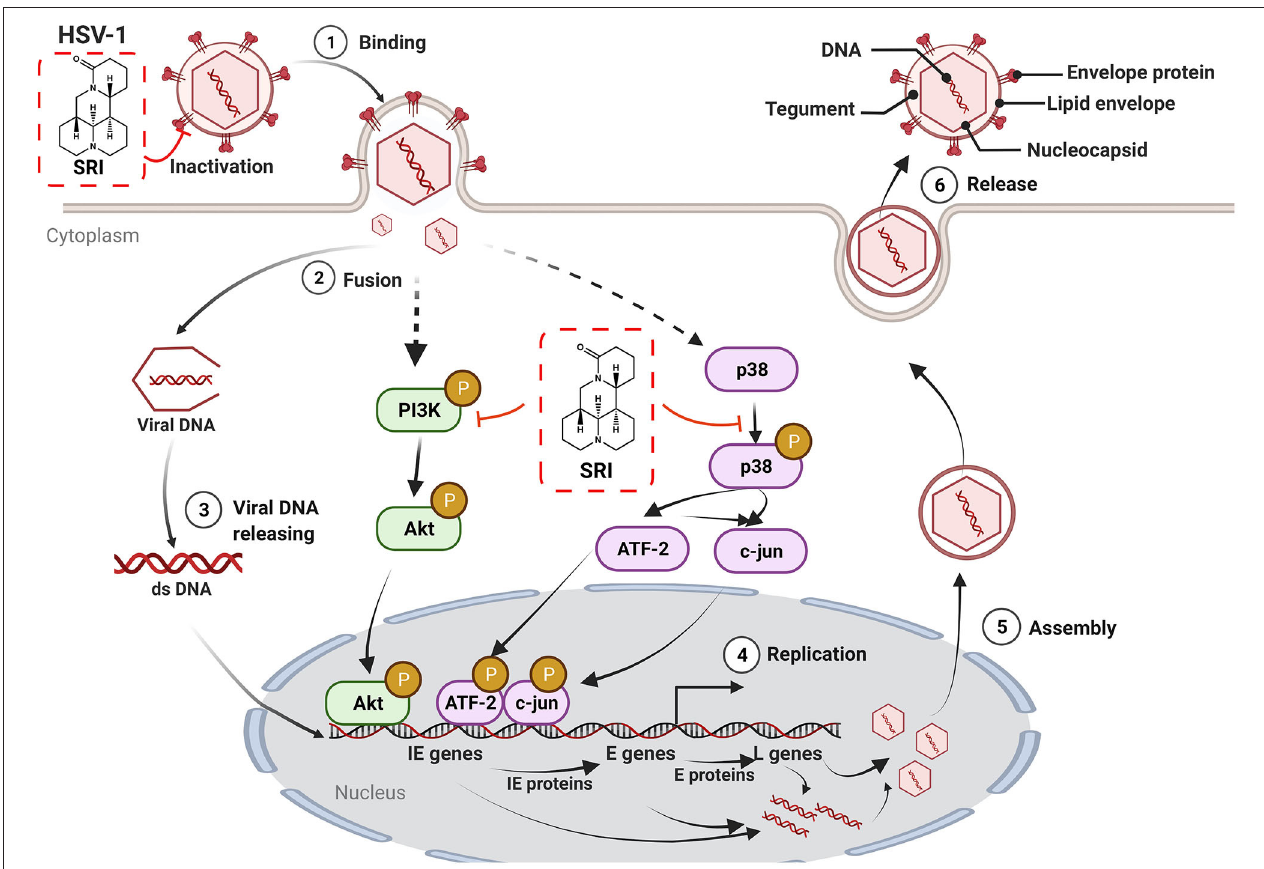
FIGURE 8 | The possible mechanism of action of SRI in HSV-1-infected cells. SRI can directly inactivate HSV-1 virus particles. More importantly, SRI may also suppress the activation of HSV-1-induced cellular PI3K/Akt and p38 MAPK pathways to reduce the subsequent replication of the virus and hence the production of virus progeny particles. Binding (1), fusion (2), viral DNA release (3), DNA replication (4), assembly of virus progeny particles (5), and release (6) (red T line represents inhibition and black arrow marks promotion,